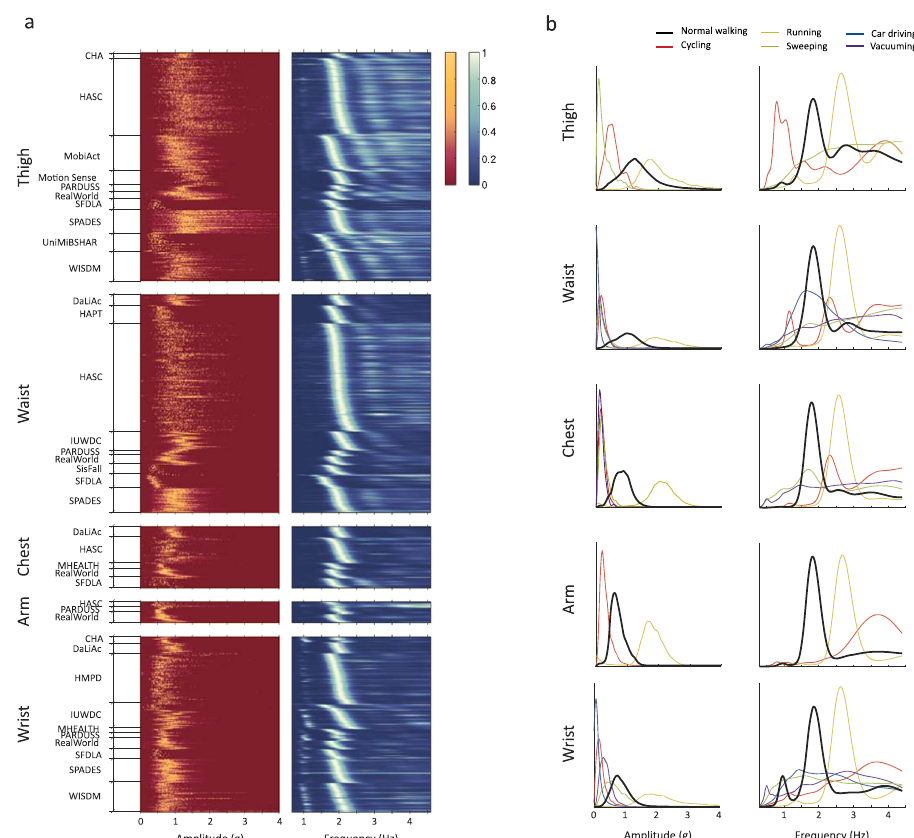
Fig. 4 Exploratory data analysis. a Distribution of accelerometer-based signal features (peak-to-peak amplitude and wavelet coef fi cients) for various sensor body locations and studies during normal walking. Each row corresponds to a subject while color intensity corresponds to the frequency of a given value for this subject. In each study, subjects were sorted by the location of maximum wavelet coef fi cient between 1.4 Hz and 2.3 Hz. b Cumulative cross-study distribution of peak-to-peak amplitude and wavelet coef fi cients for normal walking and other common daily activities for various sensor body locations. Distributions were normalized to have equal area under the curve. Distributions reveal that amplitude- and frequency-based features are well suited to separate walking from other activities. They also reveal visual differences between frequency-based features at locations typical to smartphone (thigh, waist, chest, arm) and smartwatch